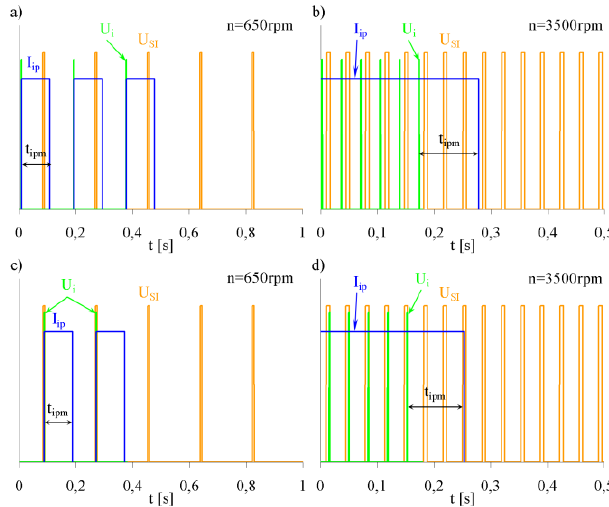
Fig. 4. Auxiliary injection signal at low (a) and high (b) engine rotational speed The injection pulse elongation time should be equal to the time of two strokes at the minimum rotational speed n = = 600 rpm, i.e. t = 0.1s. At higher rotational speeds, the ipm U signals generated for individual injection pulses will ip overlap creating one pulse ending at t from the time of the p last injection pulse